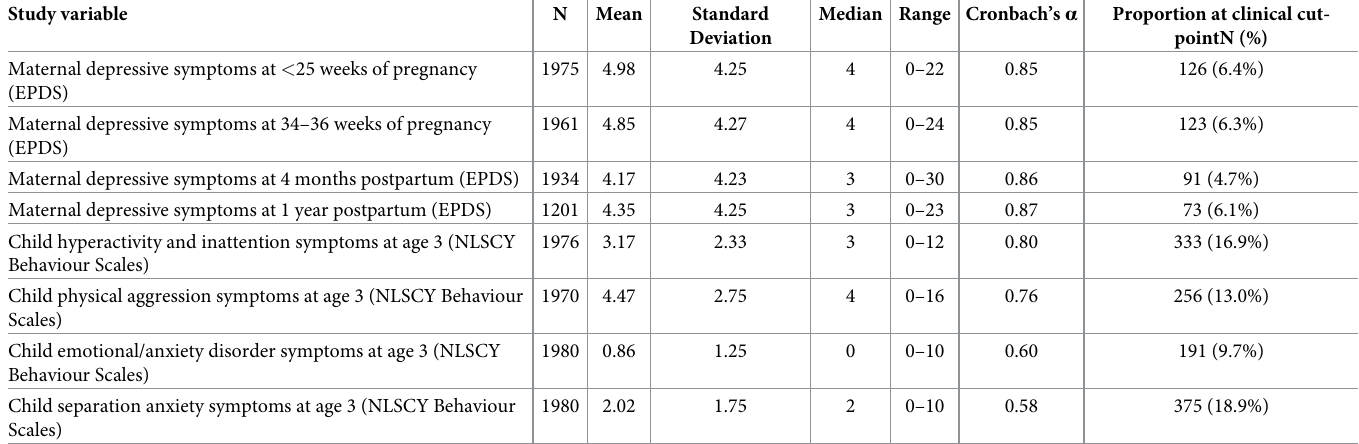
Table 2. Descriptive statistics for maternal depression and child externalizing and internalizing behavior variables. Study variable